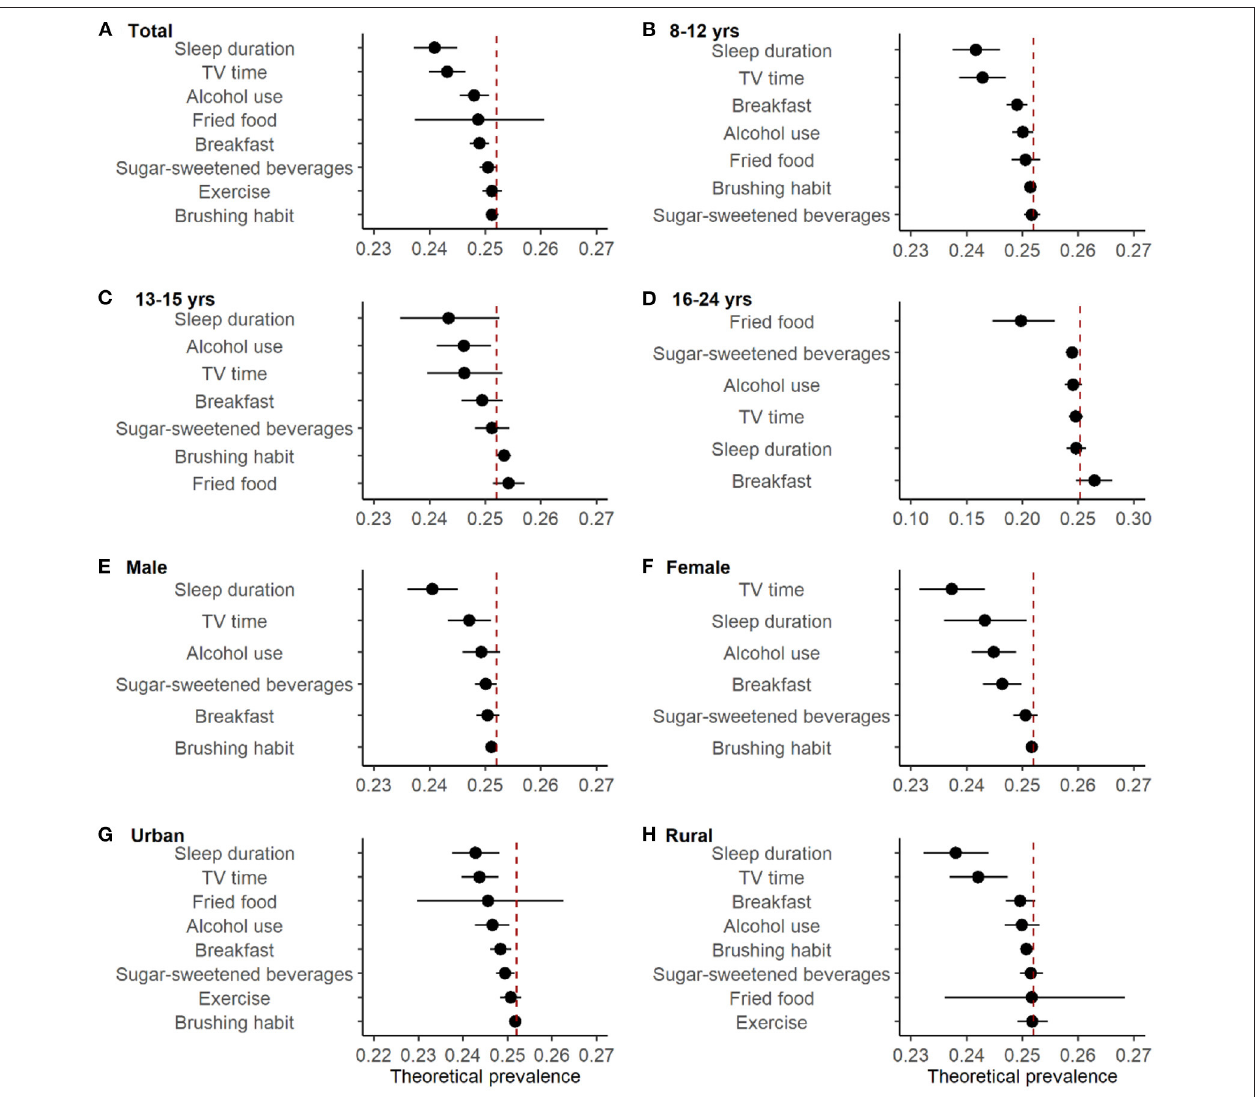
FIGURE 2 | Predicting prevalence of overweight/obesity if the risk factor was removed, ranked by the magnitude of rate deduction. Models were adjusted for age, sex, city, urban/rural area and all other factors. Dots were the estimated values. Error bars were 95% confidence intervals. (B, C) exercise wasn’t shown because it was insignificant and had too wide CI to be shown. (D) toothbrushing habit wasn’t shown because it was insignificant and the number of people who occasionally or didn’t brush their teeth every day was small (54/11205). (E, F) fired food and exercise weren’t shown because they were insignificant and had too wide CI to be